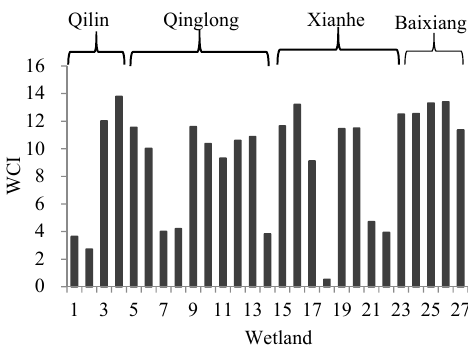
Figure 6. WCI of different wetland watersheds.